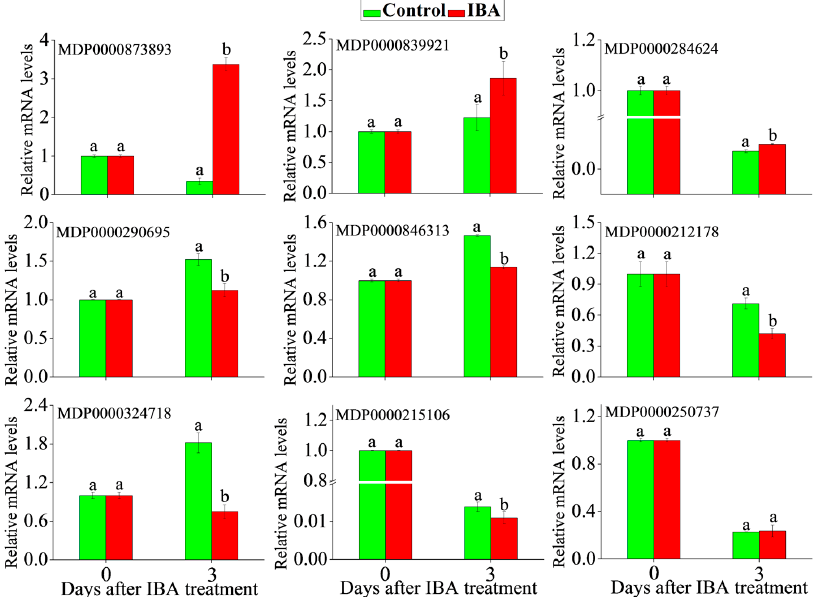
Figure 5. Analysis of change in mRNA level via qRT-PCR for several differential proteins mapped in phytohormone signaling pathway. The transcript levels at 0 d were normalized to value 1. Statistically significant differences in IBA-treated cuttings and control on each day were indicated with ‘a’ and ‘b’. Indole-3-acetic acid-amido synthetase (MDP0000873893), ACC oxidases (MDP0000839921), abscisic acid receptor PYL9 (MDP0000284624), indole-3-acetate O -methyltransferase 1 (MDP0000290695), two-component response regulator ARR1 (MDP0000846313), two-component response regulator ARR5 (MDP0000212178), ethylene-responsive transcription factor 4 (MDP0000324718), ABSCISIC ACID-INSENSITIVE 5-like protein (MDP0000215106), two-component response regulator ARR3 above the bars indicate a statistically significant difference ( p < 0.05), according to two-tailed t -test.